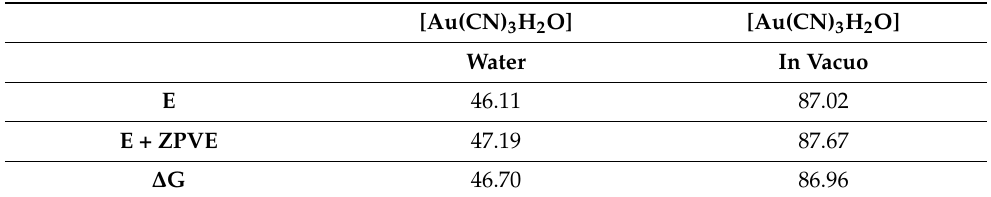
Figure 6. The structure of the gold(III) tricyanide aquo complex, [Au(CN) 3 H 2 O]. The value indicates the Au-O (2.123 Å) length. Atom coloring: Au—gold, C—grey, O—red, N—blue, and H—white. It should be noted that although the complex with water serving as ligand is stable, the substitution of CN − ligand by water is both energetically and thermodynamically not favorable. This explains why the dissociation of gold(III) tetracyanide in water environment is not observed. Table 6. Energy (E); energy corrected by the zero-point vibrational energy (E + ZPVE); Gibbs free energy ( ∆ G) of the complex formation of gold(III) tricyanide aquo complex. In vacuo—results obtained without solvation. Water—results obtained using PCM implicit solvation model. All values are in